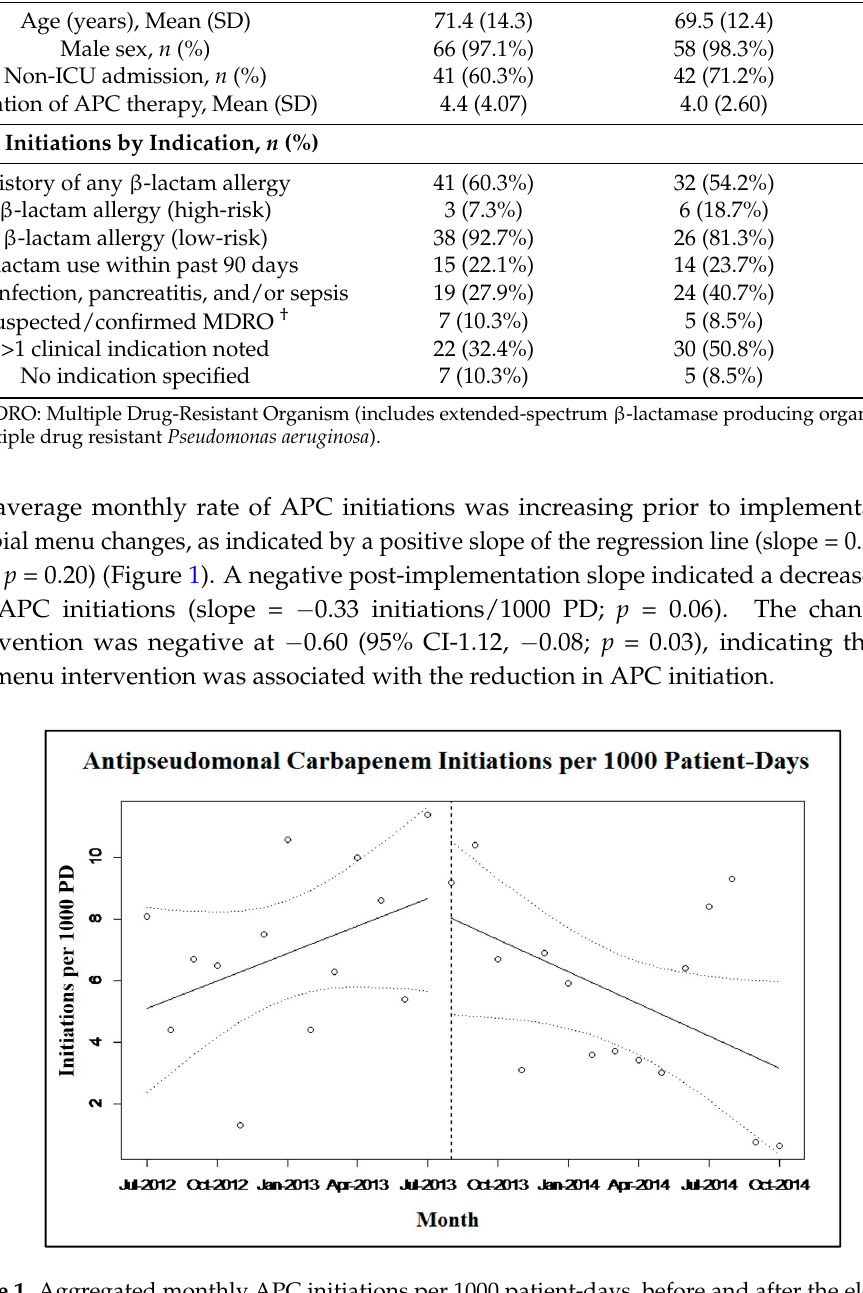
Figure 1. Aggregated monthly APC initiations per 1000 patient-days, before and after the electronic intervention was implemented (indicated by vertical dashed line and 95% confidence intervals indicated by sloped dashed lines).